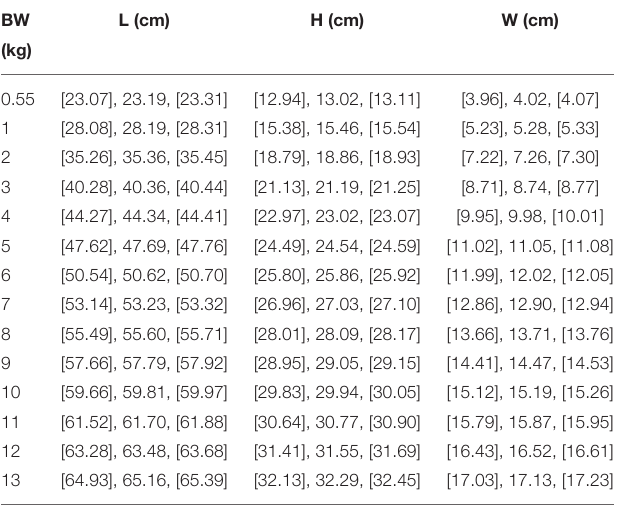
TABLE 1 | Dimension mean and Confidence Intervals (95%) in [ ] of dimensions (cm) for based on the body weight (L, length; H, height; W,